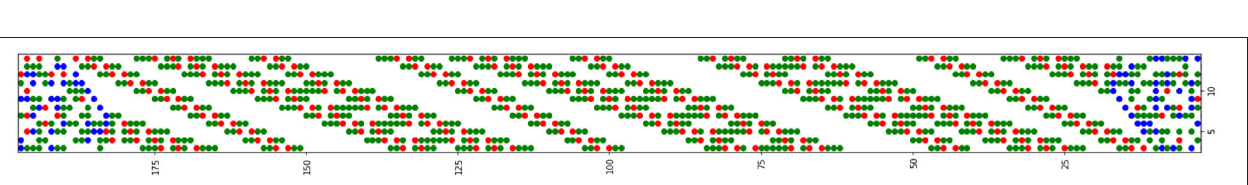
FIGURE 2 | (cid:127) is a square [0,100] × [0,100], and we put 3 grains at every vertex of the lattice inside (cid:127) and drop 1 additional grain to each blue point. On the left we see the initial phase of the relaxation. The central picture shows an intermediate phase. On the right we see the final result.